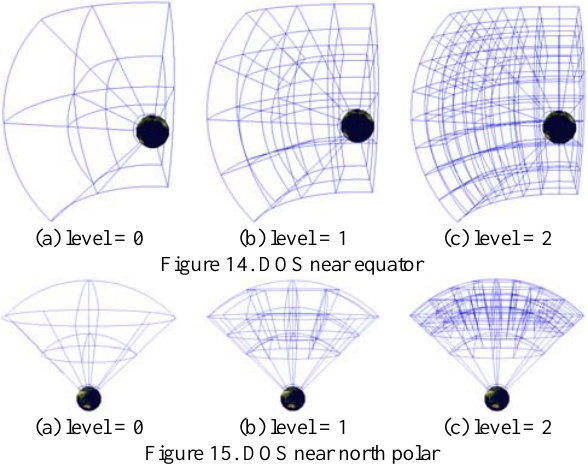
Figure 15. DOS near north polar